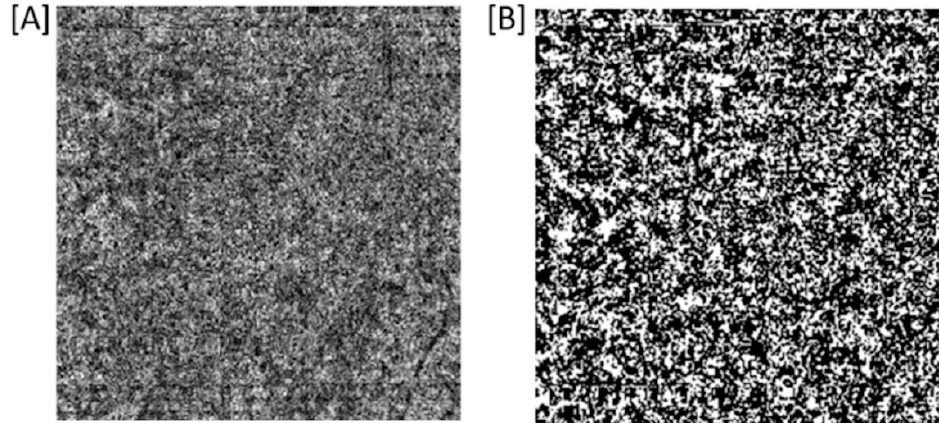
Figure 4. Choriocapillaris flow void of right eye in optical coherence tomography angiography OCT-A CC: en-face optical coherence tomography angiography (SS-OCT, PLEX Elite 9000; Carl Zeiss Meditec, Inc., field of view of 6 × 6 mm centered on fovea) image of the choriocapillaris (CC) layer ( A ) without image processing, and ( B ) after Phansalkar thresholding as used for flow void analysis.